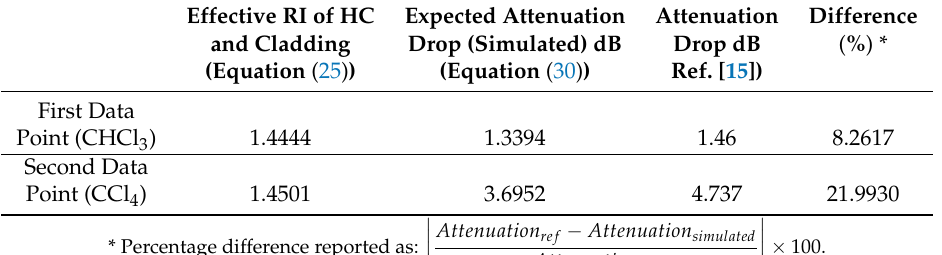
Table 8. Comparison between experimental data points in [15] and the simulated calibration curve. Effective RI of HC Expected Attenuation Attenuation Difference and Cladding Drop (Simulated) dB Drop dB ( % ) * (Equation (25) ) (Equation (30) ) Ref. [15]) First Data Point (CHCl 3 )